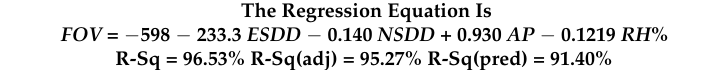
Table 5. Statistical results of ESDD -, NSDD -, AP -, and RH -based model for agricultural- and biological-pollution-contaminated